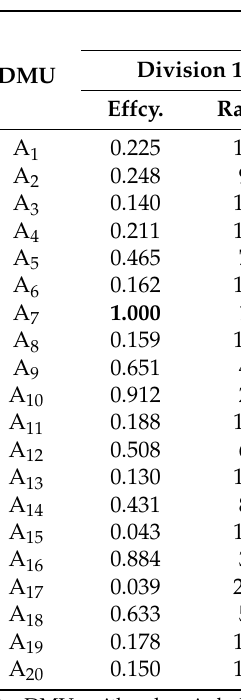
Table 9. The results of the separation